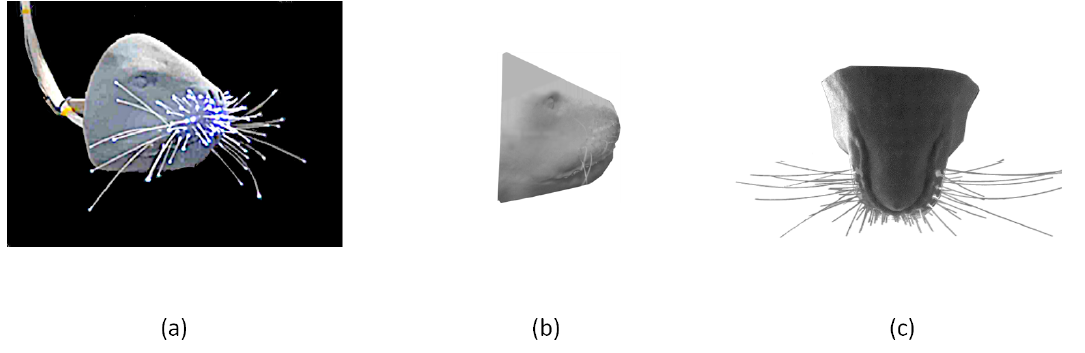
Figure 1. Three-dimensional (3D) printed model of the pinniped head. ( a ) captured image of the head while the optical fibres are illuminated. ( b ) side view ( c ) plan view of the